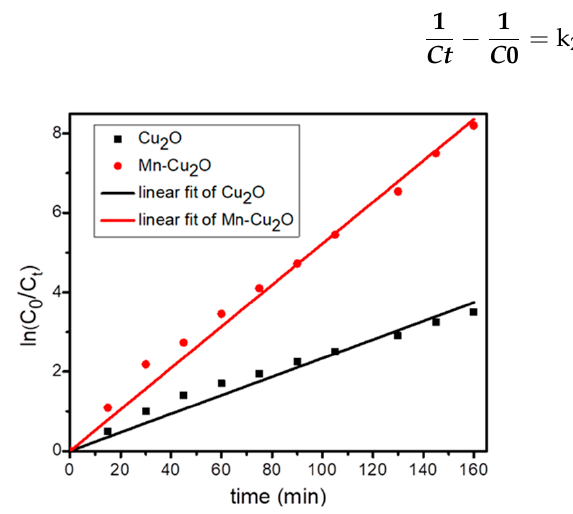
Figure 8. Plot of ln(C 0 /C) versus